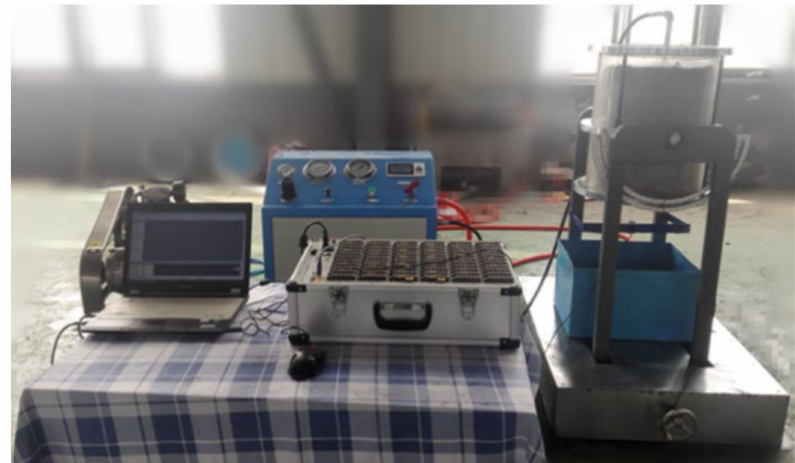
Figure 1. Test system.